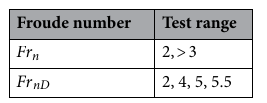
Table 4. Range of Froude number of experimental tests.